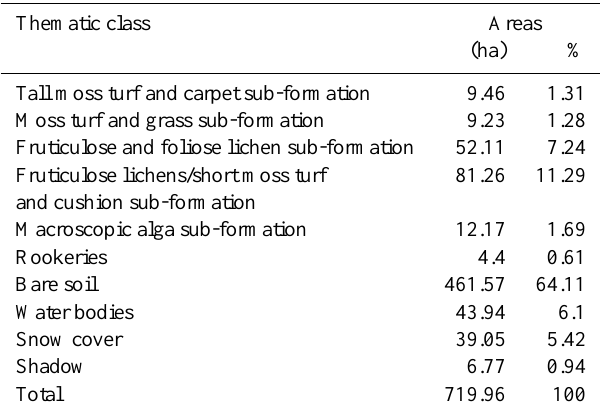
Table 3. Plant community classes and their relative areas on Potter